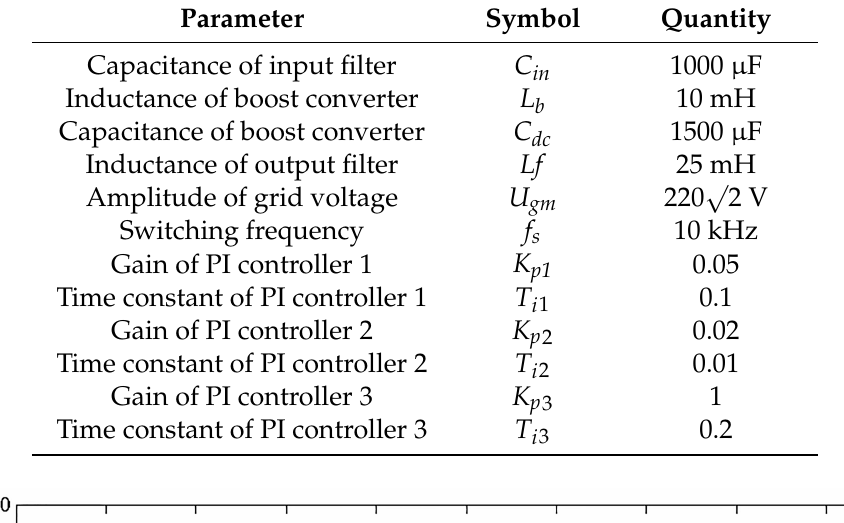
Table 2. Converter parameters.